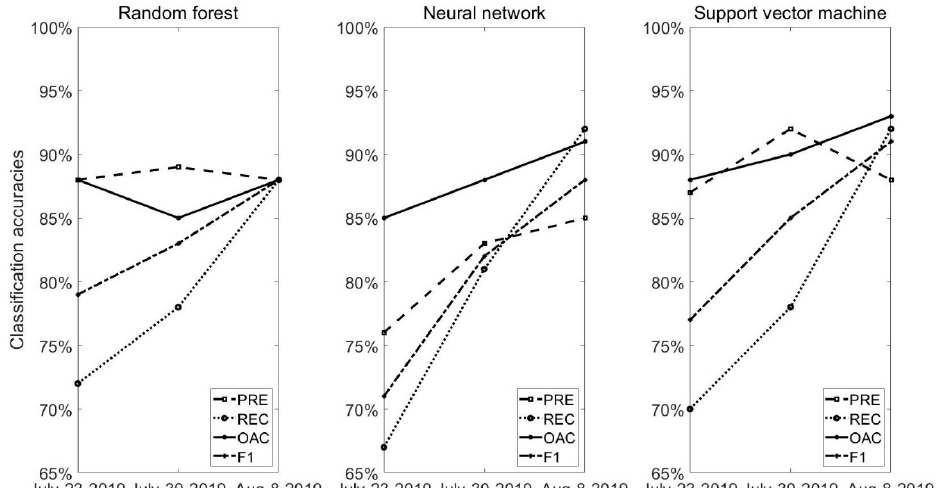
Figure 13. Classification accuracies by random forest, neural network, and support vector machine for lodging detection on three di ff erent dates datasets, where PER, REC, OAC, and F1 denote precision, recall, overall accuracy, and F1 measurement,